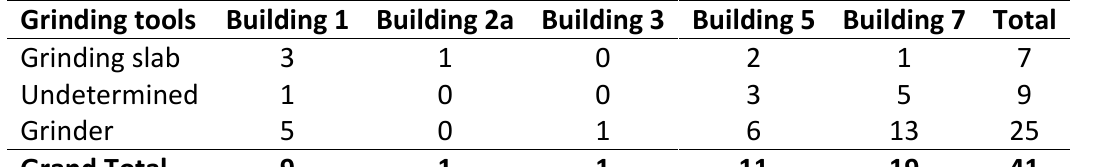
Table 3. Frequencies of grinding tools within the AVGI I houses. Differences in the quantities of grinding tools are the result of the different degree of excavation of each house.